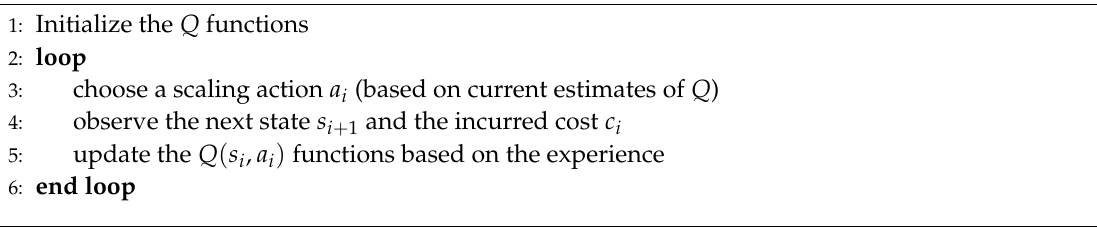
Algorithm 1 RL-based operator elastic control